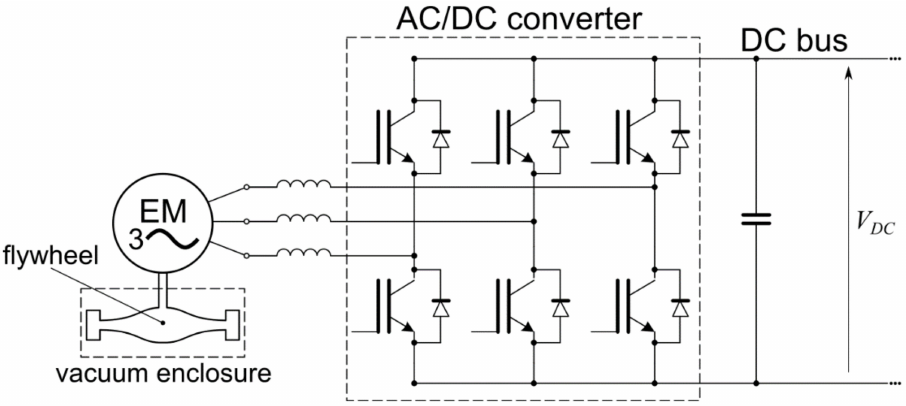
Figure 10. Sketch of the flywheel energy storage system.